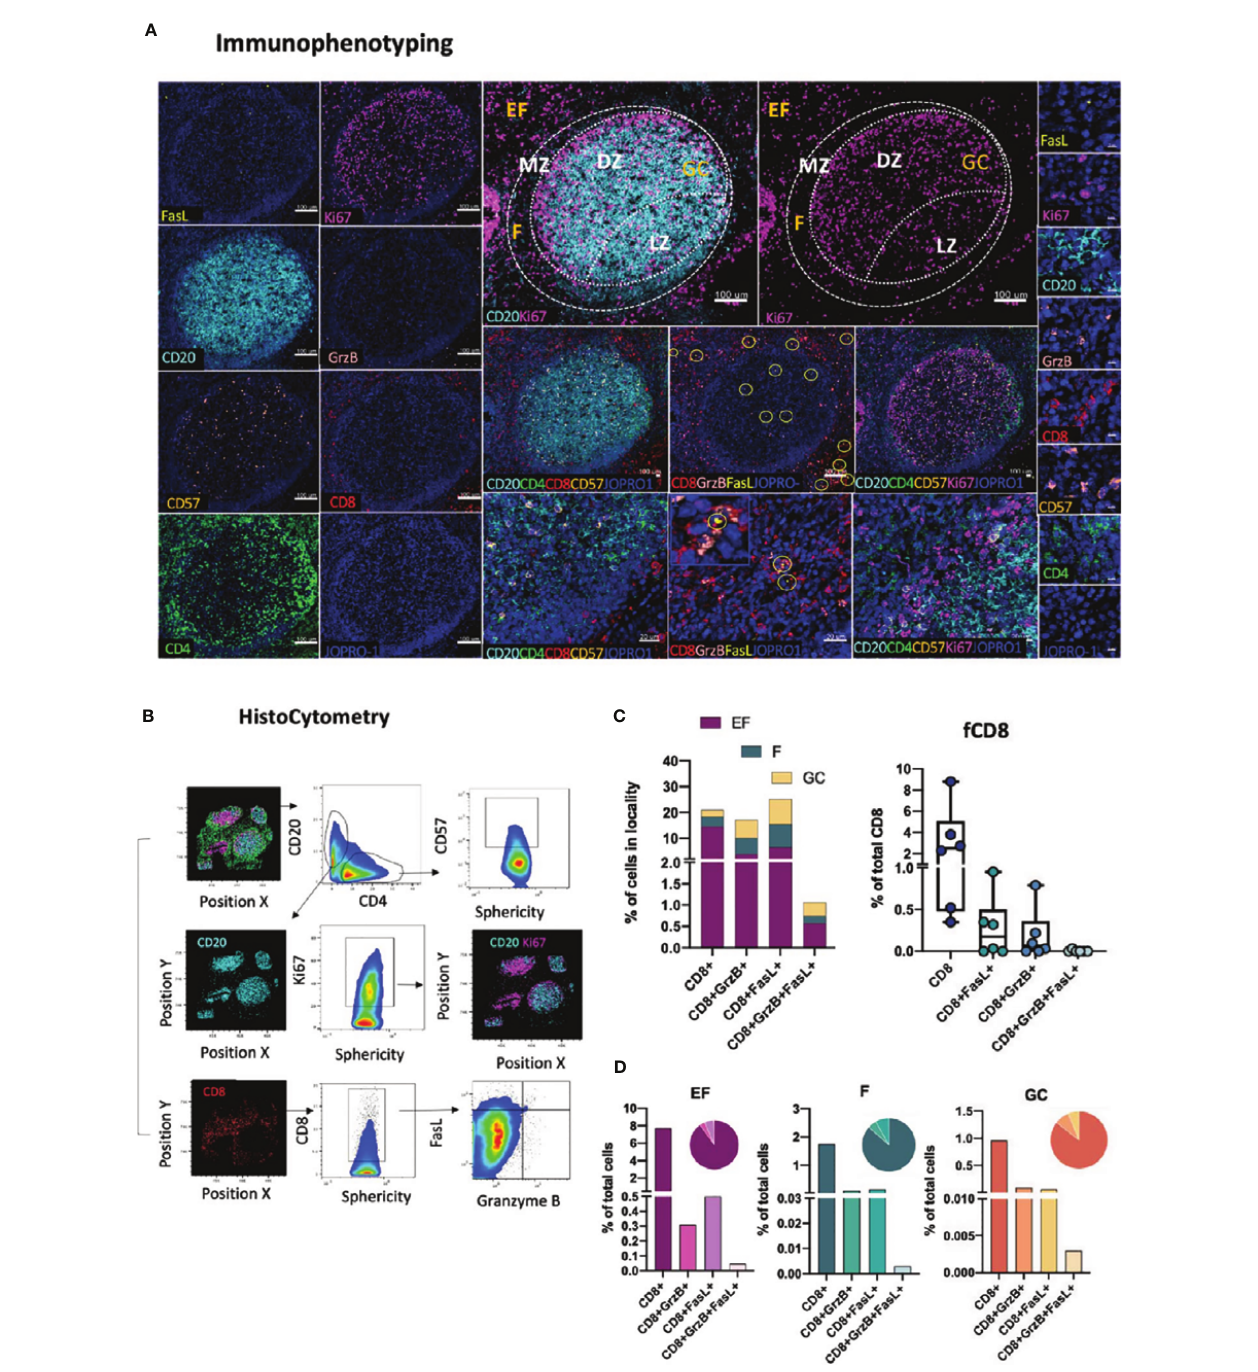
FIGURE 4 | Development of a multispectral panel for the topological examination of CD8 T cells. (A) Representative example of antibody staining patterns for FasL (yellow), Ki67 (magenta), CD20 (cyan), Granzyme B (pink), CD57 (orange), CD4 (green) and the nuclear marker JOPRO-1 (blue) and distribution of each protein marker with respect to the MZ, LZ and DZ (middle panels). Yellow circles in lower middle panels denote individual FasL events. (B) Gating strategy used for the immunophenotyping of various CD8 T cell populations (CD8 hi ; CD8 hi GrzB+, CD8 hi FasL+ and CD8 hi GrzB+ FasL+) in in GC (CD20 dim Ki67 hi ), F (CD20 hi/dim )and EF (CD20 lo ) areas. (C) Box plots and bar graphs showing the relative frequencies of four distinct CD8 T cell populations in EF, F and GC; the frequencies of follicular CD8 hi ; CD8 hi GrzB+, CD8 hi FasL+ and CD8 hi GrzB+ FasL+ in six distinct follicles and (D) proportion of each CD8+ cell subset within each locality (EF, F and GC) as a percentage of total cells. Each circle represents a follicle and each color stands for a distinct subpopulation. Images were acquired at 40x (NA 1.3) with 1% magni fi cation. Scale bars are 100um for all panels displaying an entire follicle), 20um in the middle panel close ups and 5um in the right panel single staining close